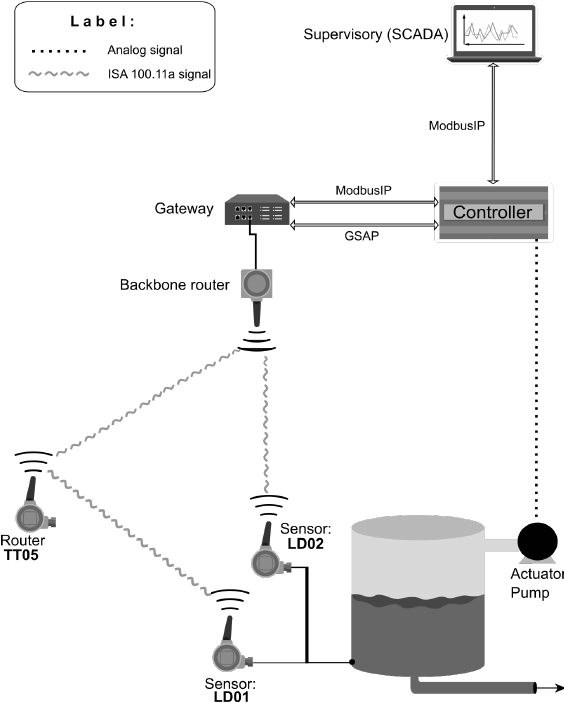
Figure 1. ISA 100.11a network control system